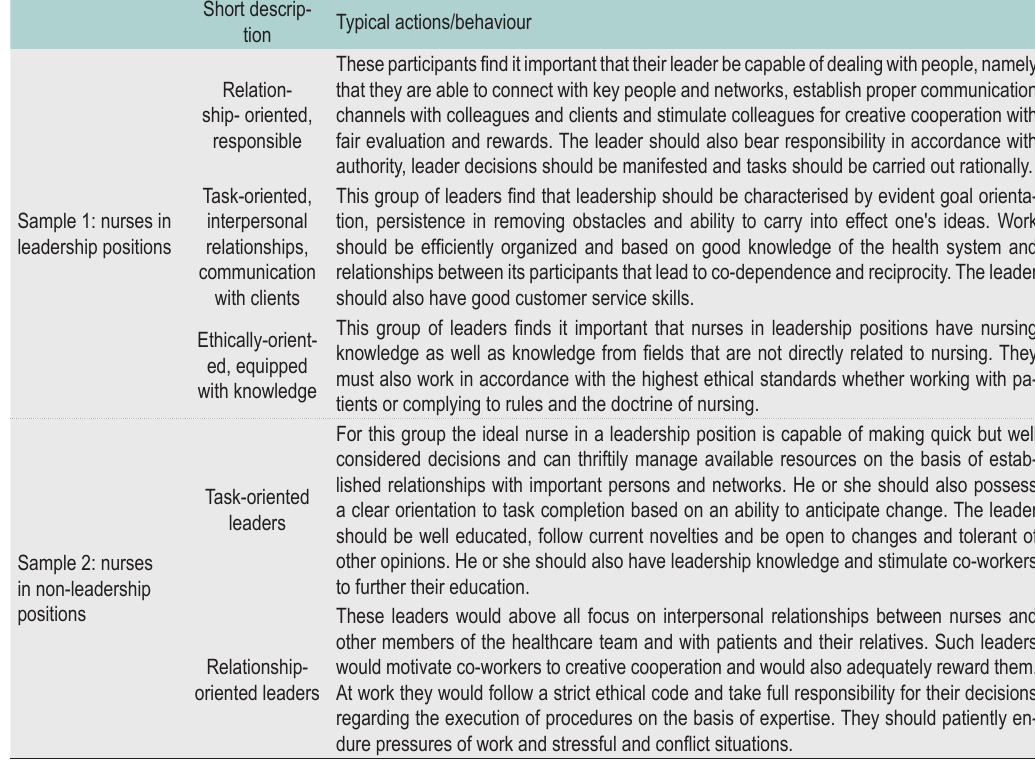
TABLE 5. Attributed grades by individual competences – comparison between both